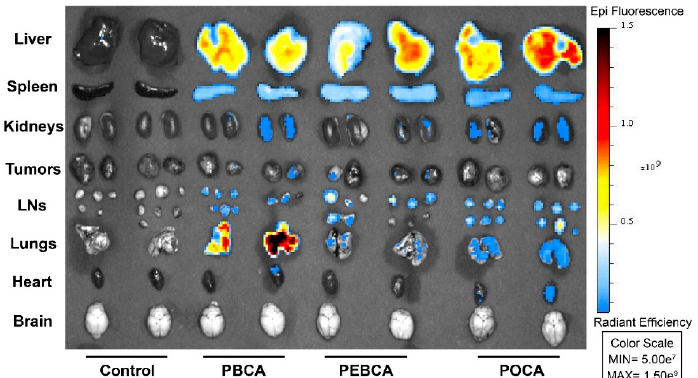
Figure 1. Biodistribution of PACA NPs containing the fluorescent dye NR668 in mice bearing MAS98.12 tumors. Organs were removed 24 h after i.v. injection. In vivo imaging system (IVIS) was used to image liver, spleen, kidneys, tumors, lymph nodes (LNs), lungs, heart, and brain. The color scale to the right indicates radiant efficiency. Control animals did not receive any treatment.